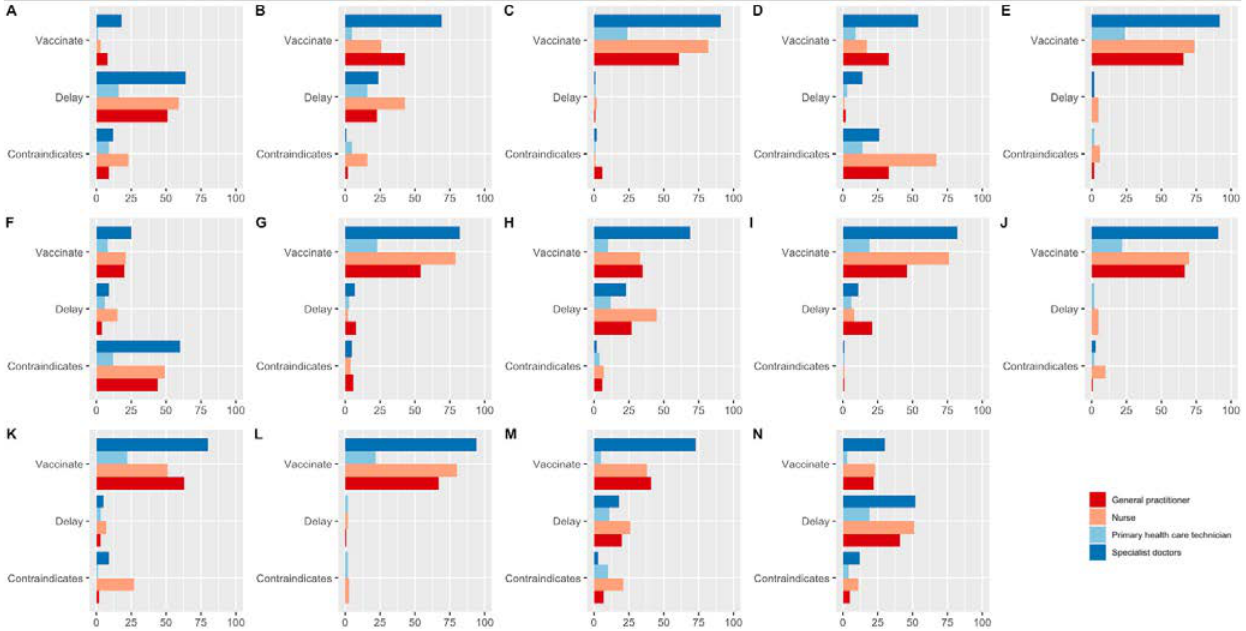
Figure 1. Bar graph of the knowledge of the personnel surveyed about false contraindications for vaccines, according to the level of health care to which they belong: ( A ). moderate fever, ( B ). use of antibiotic therapy, ( C ). children who are breastfeeding, ( D ). History of allergy to eggs, ( E ). History of mild allergic reaction to another vaccine, ( F ). History of autoimmune diseases such as agammaglobulinemia, ( G ). Children who live with pregnant women, ( H ). Children who are recovering from influenza, ( I ). History of prematurity, ( J ). DTP vaccine immunization in children with a family history of epilepsy, ( K ). Immunization of the DTP vaccine in children with a history of controlled epilepsy, ( L ). History of allergy to penicillin, ( M ). Vaccination in advance of the card, ( N ). Corticosteroid therapy.